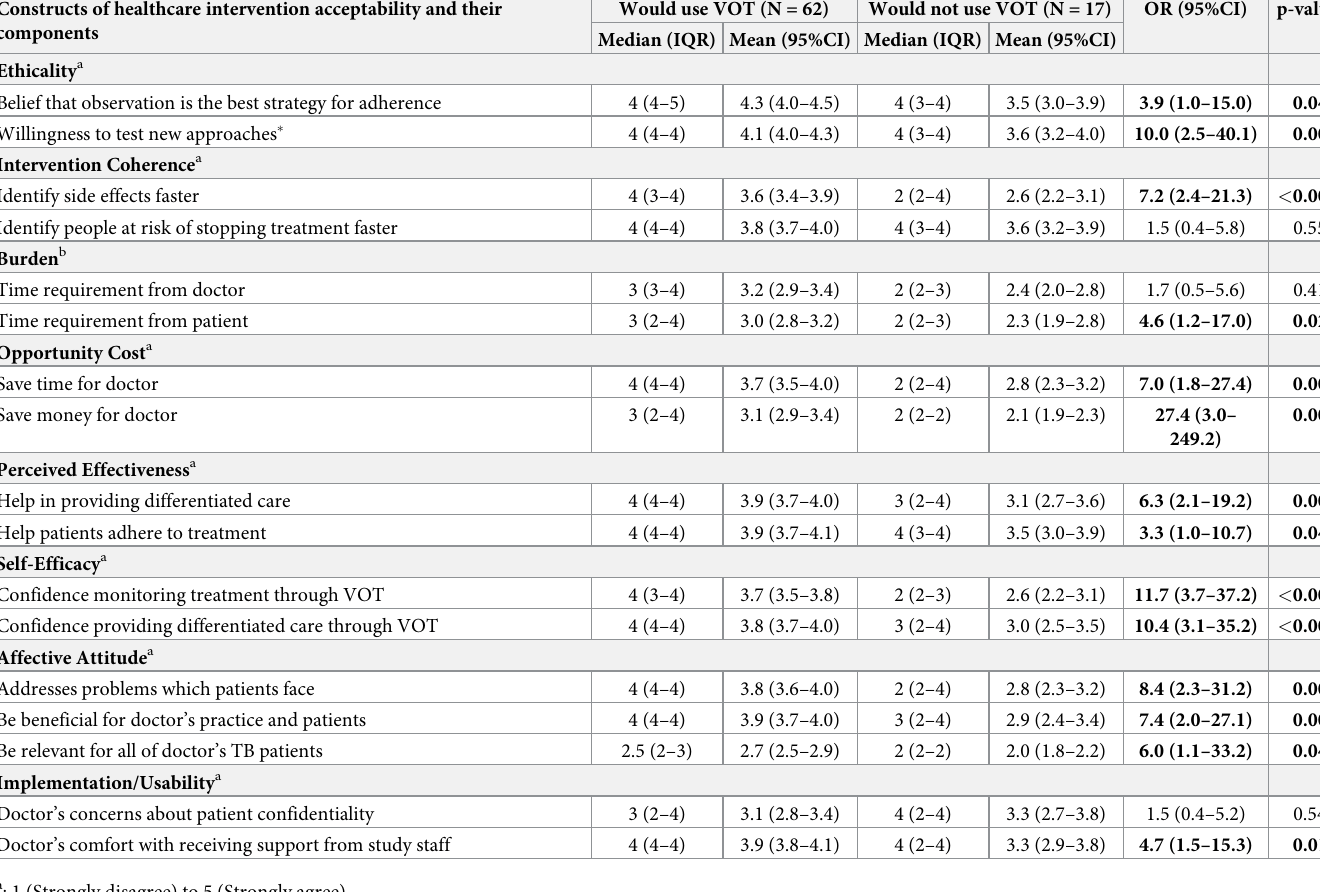
Table 3. Constructs of acceptability associated with the willingness to use VOT in all three